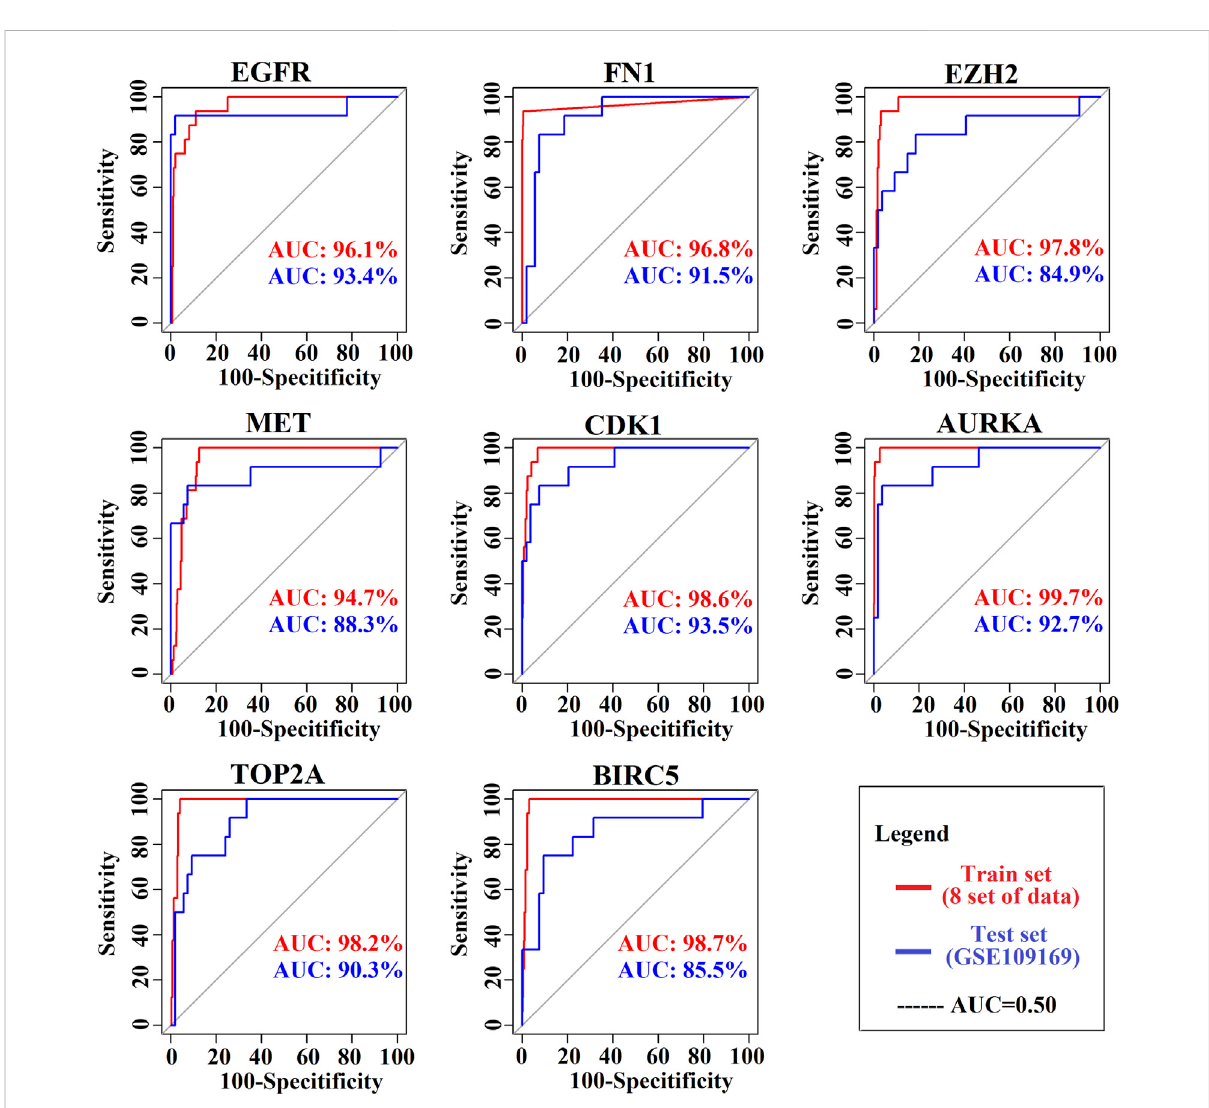
FIGURE 6 Prognostic powers of KGs were represented by ROC curves, where red indicates the prediction curve and blue indicates the validation